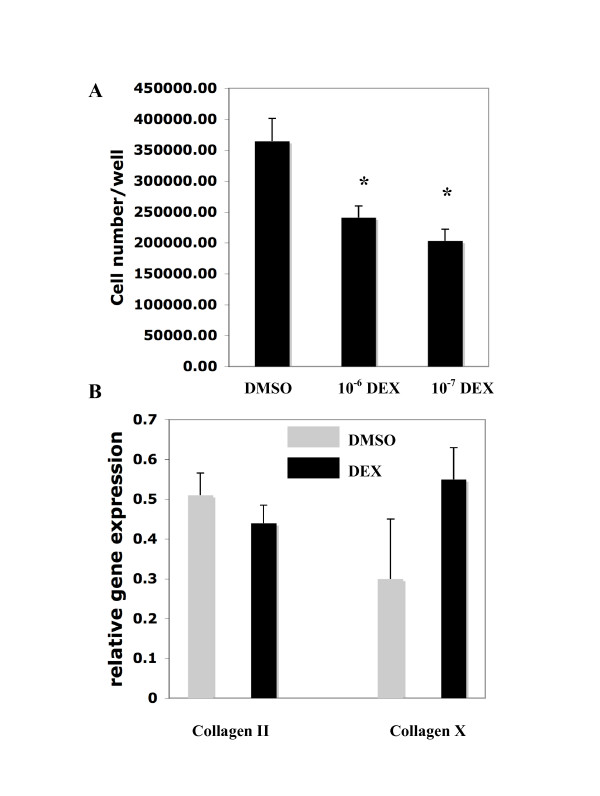
DEX treatment reduces chondrocyte cell numbers. A) Primary mouse chondrocytes were plated at a density of 100,000 cells/well, incubated with DMSO or 10-6 or 10-7 M DEX for 72 hours and counted. While cell numbers in control conditions (DMSO) increased 3.5-fold over the culture period, DEX treatment at both concentrations significantly reduced this increase. Data present averages and standard deviations from three independent experiments, performed in triplicate each (*P < 0.05). B) Primary chondrocytes were incubated with DMSO or 10-7 M DEX for 72 hours, and mRNA levels for collagen II and collagen X genes were analyzed by real-time PCR. Neither gene was affected significantly by DEX. Data represent mean ± SEM from three independent trials.